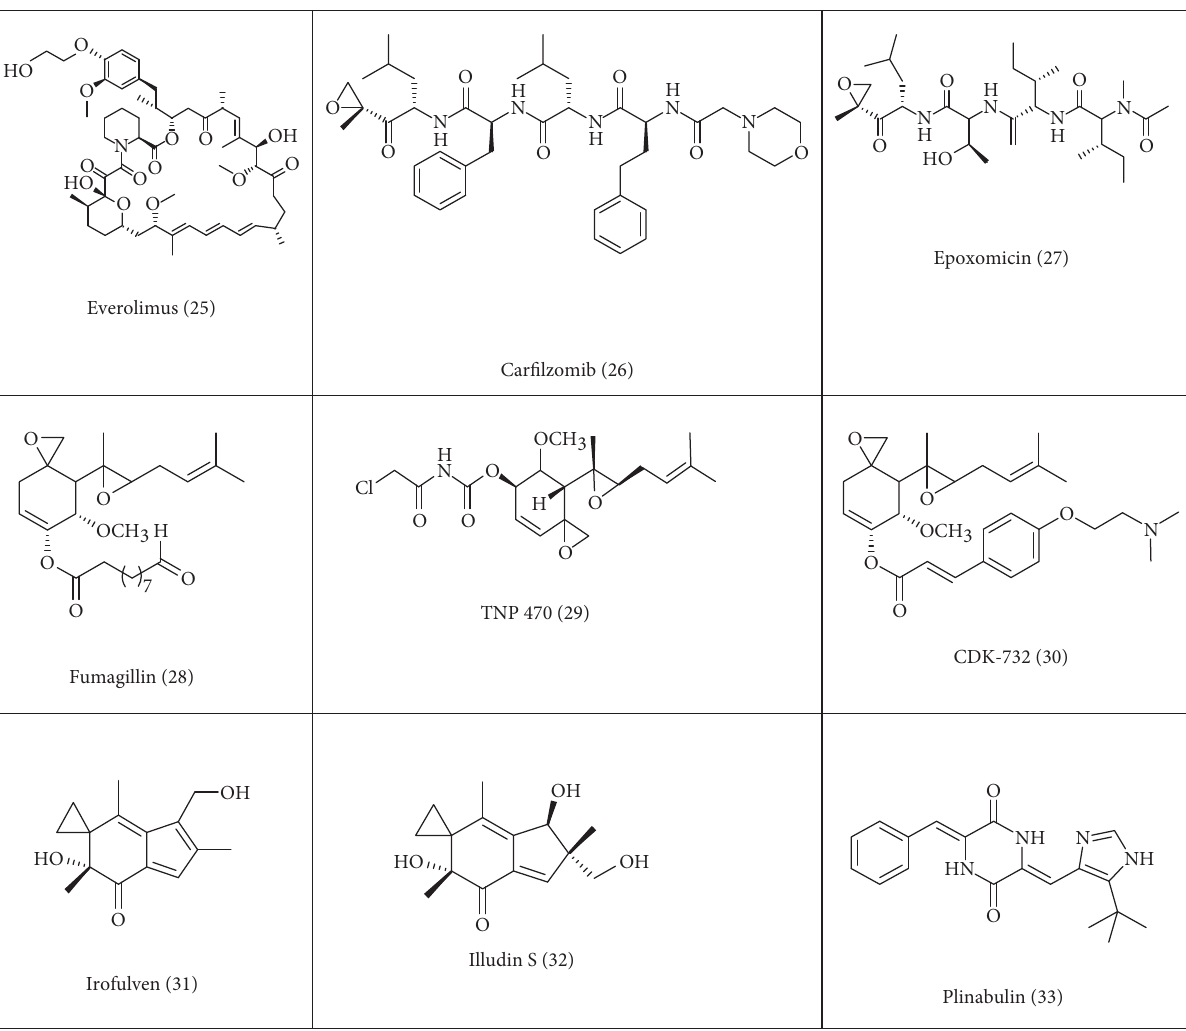
Figure 3: Chemotherapeutic agents obtained from